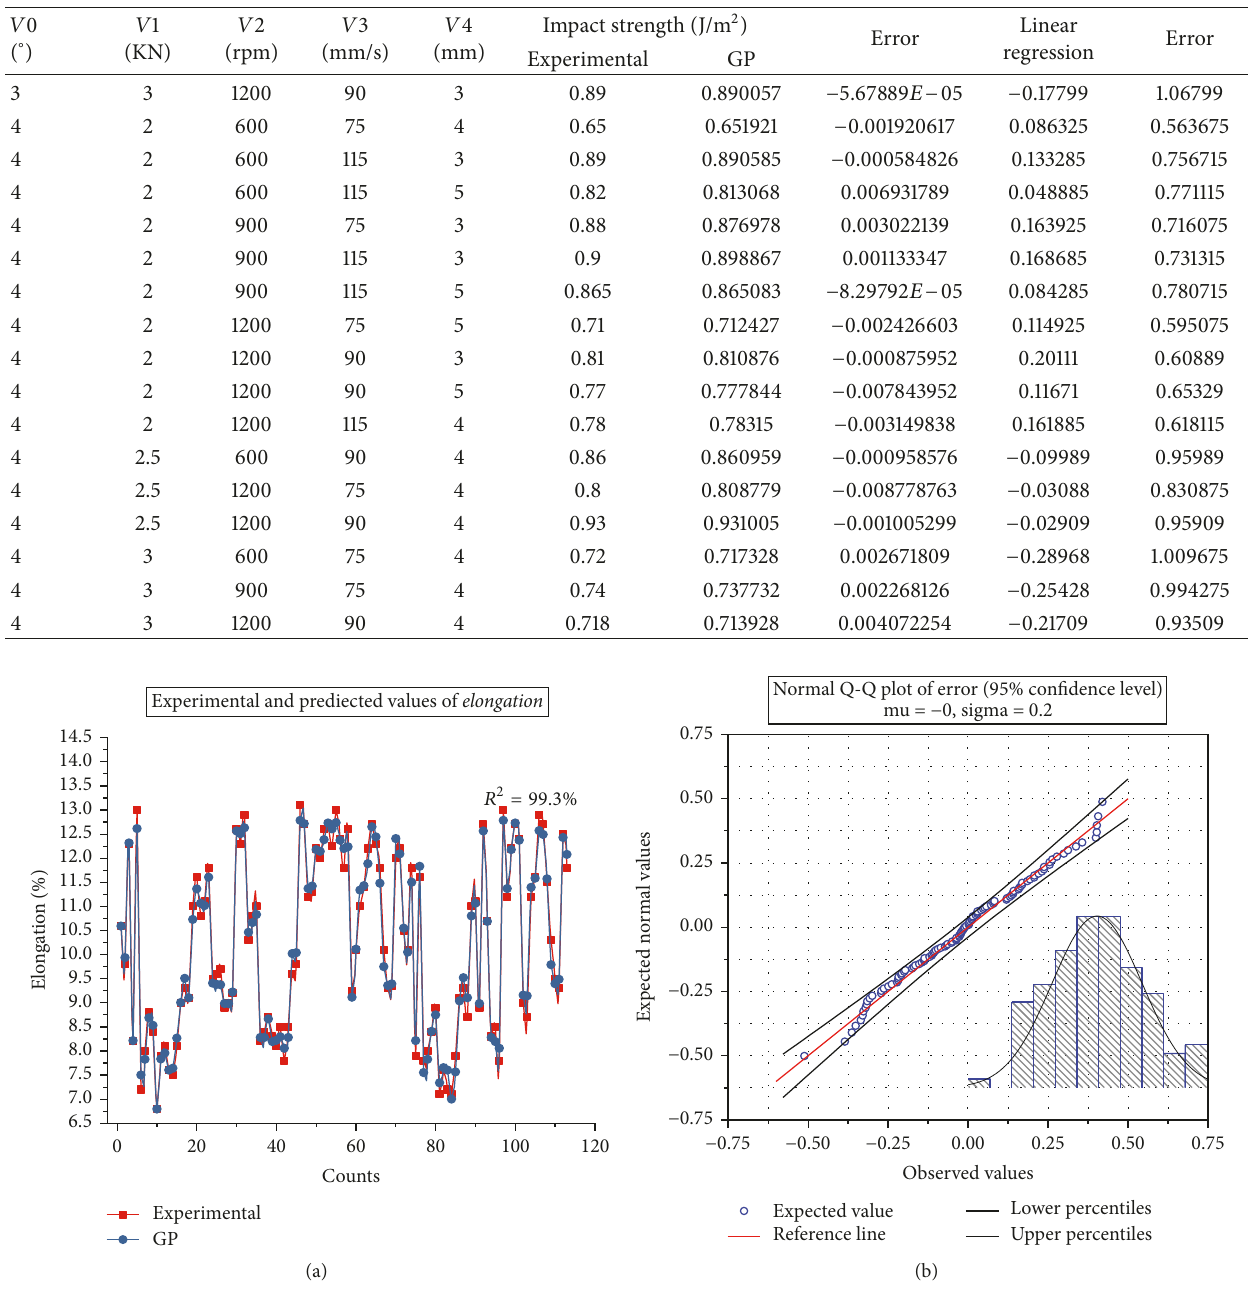
Figure 2: (a) Comparison between experimental and predicted values of elongation and (b) normal Q-Q plot of error between experimental and GP